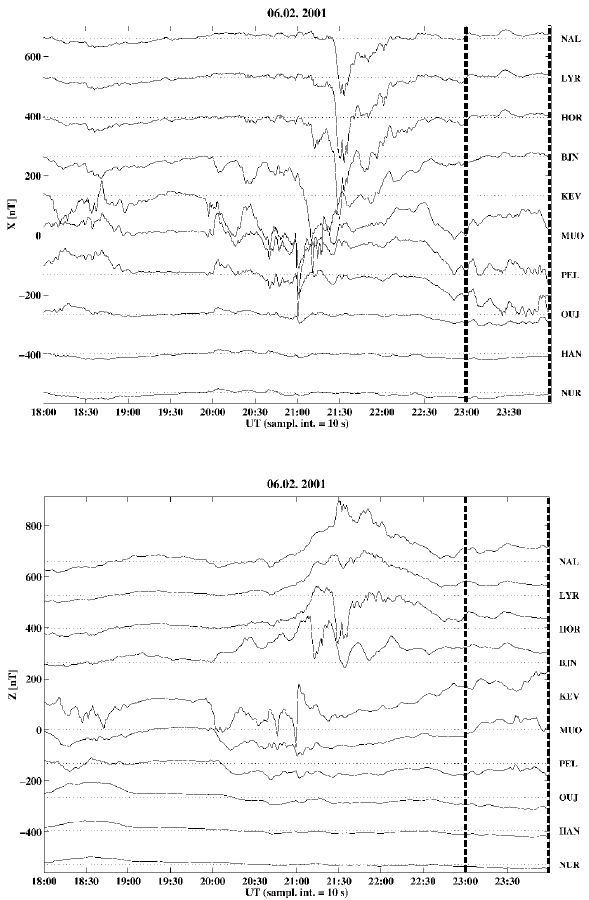
Fig. 2. X (geographic northward) and Z (vertical downward) com- ponent magnetograms for a selected meridional chain of IMAGE stations on 6 February 2001, 18:00–00:00 UT, in